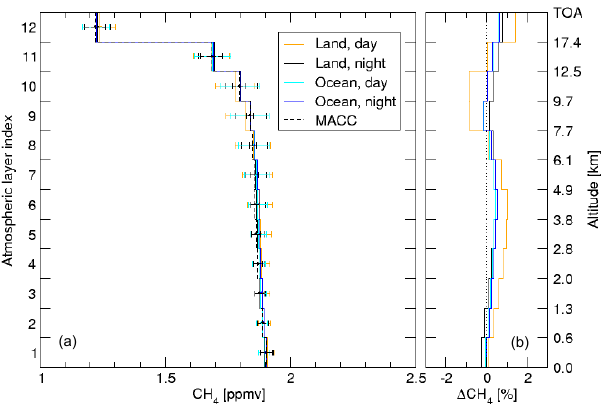
Figure 9. (a) Retrieved methane profiles from GOSAT-TIR mea- surements over TCCON station Bialystok with the bias-correction scheme included in the retrieval algorithm. The data are divided for different scenes; land and ocean scenes during daytime (orange and cyan, respectively) and nighttime (black and blue, respectively). The dashed lines refer to the MACC profiles for the daytime land scenes, and are very similar to the profiles for the other 3 scenes and have been left out for clarity. (b) The relative difference between the GOSAT-TIR retrievals and the MACC